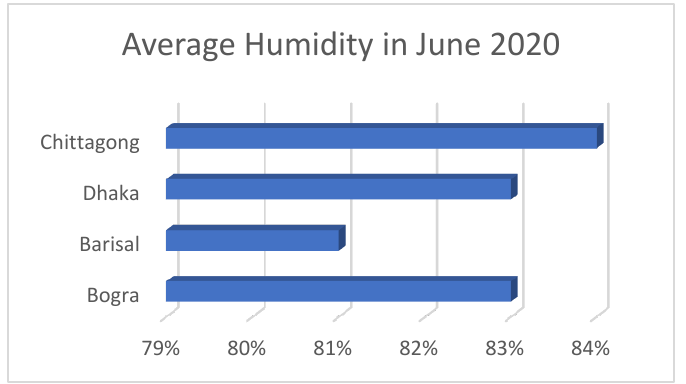
Figure 5. Average humidity comparison chart in June 2020. Table 4. Deployment of the fabricated hand sanitizer dispenser units in various major cities in Bangladesh.